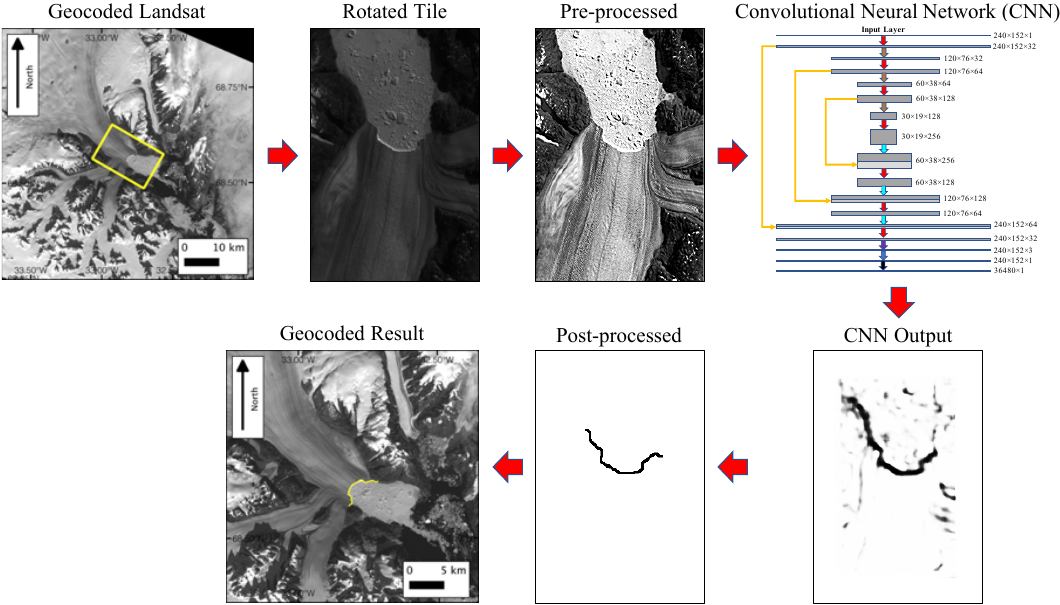
Figure 1. The outline of our methodology: Geocoded Landsat images are trimmed and rotated so that glacier flow is in the y-direction. The images are pre-processed and fed into to a Convolutional Neural Network (CNN) for training (refer to Figure 2 for a zoomed- in version of the CNN panel). The CNN is used to predict new calving front positions, which are post-processed and converted back to geocoded